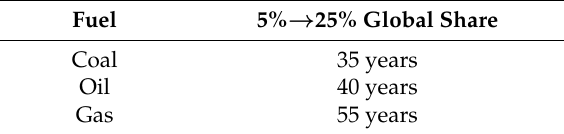
Table 1. Time for coal, oil and gas to achieve given shares of total global energy supply